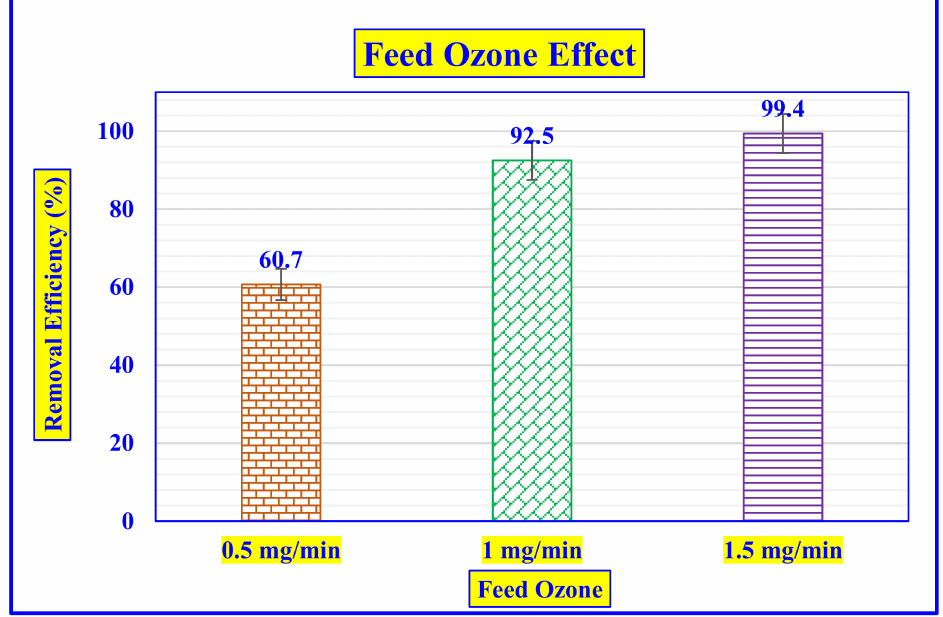
Figure 4. Ozone dose effect on catalytic ozonation processes (As = 69 ± 4 µ g/L; O 3 = 0.5 mg/min,